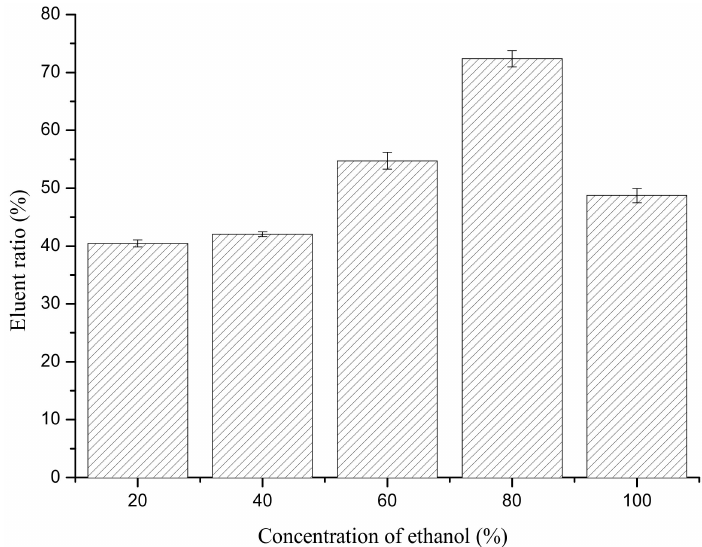
Figure 6. E ff ect of ethanol concentration on the de adsorption ratio of amygdalin from the XDA-1